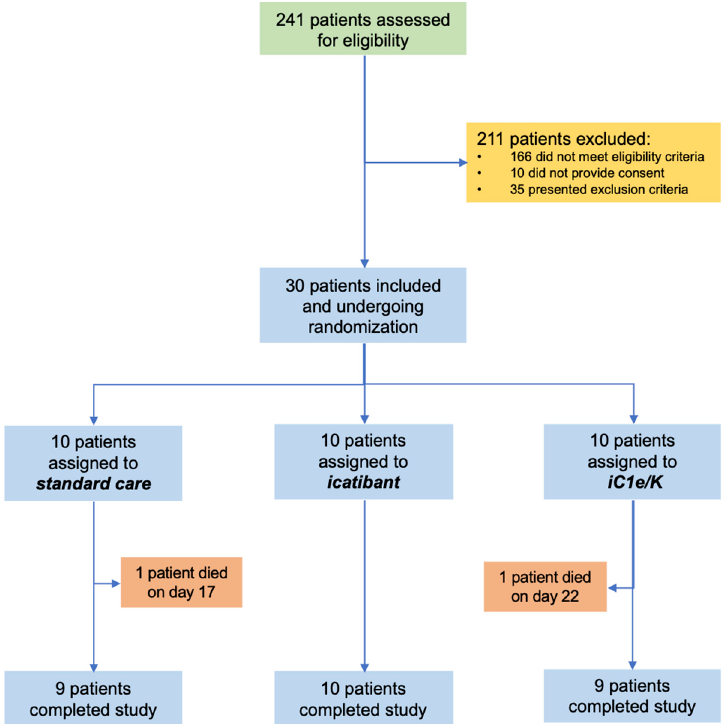
Figure 1. Schematic representation of patient screening, selection, and randomization. iC1e/K, inhibitor of C1 esterase/kallikrein. Table 1. Baseline parameters of patients included in the